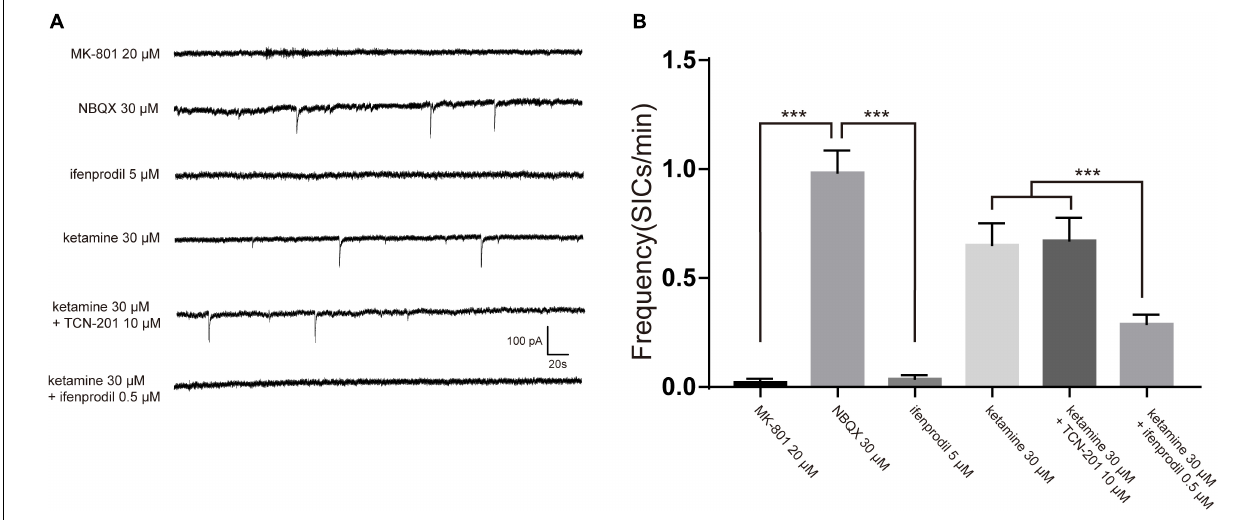
FIGURE 5 | The inhibition of SICs by ketamine was enhanced by selective antagonist of GluN1/GluN2B receptor. (A) Example traces of SICs with different antagonists administration. (B) Statistical summary of SICs frequency affected by different antagonists. Differences with statistically significant ( ∗∗∗ p < 0.001, compared with control) were verified by one-way ANOVA followed by Brown-Forsythe test. Data were presented as mean ± SD.